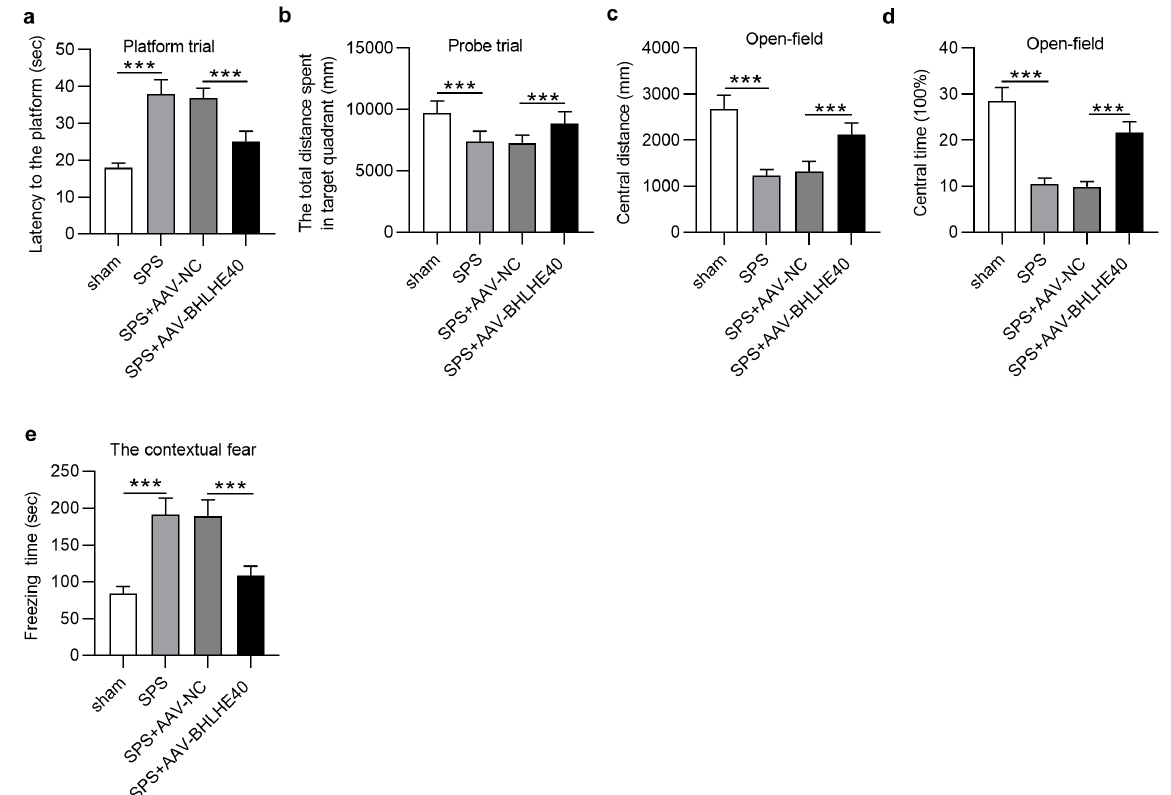
Figure 4. BHLHE40 overexpression mitigated PTSD-like behaviors of mice. (a) The escape latency of mice of sham, SPS, SPS+AAV-NC, SPS+AAV-BHLHE40 groups (n=9/group) in the visible platform trial on day 41. This experiment was conducted 3 times. (b) Total distance that mice of sham, SPS, SPS+AAV-NC, SPS+AAV-BHLHE40 groups (n=9/ group) spent in target quadrant in the probe trial on day 41. This experiment was conducted once. (c-d) The distance and time that mice of sham, SPS, SPS+AAV-NC, SPS+AAV-BHLHE40 groups (n=9/group) spent in the